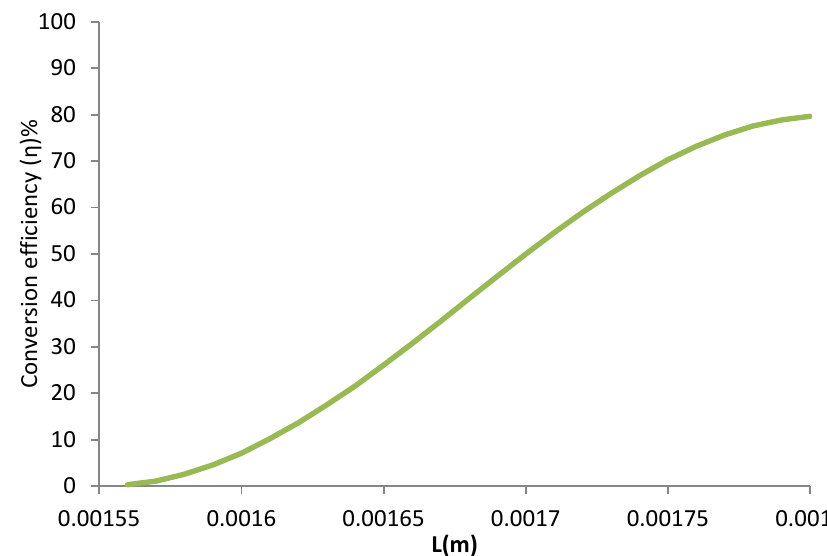
Fig.8: Conversion efficiency vs. length of nonlinear crystal at